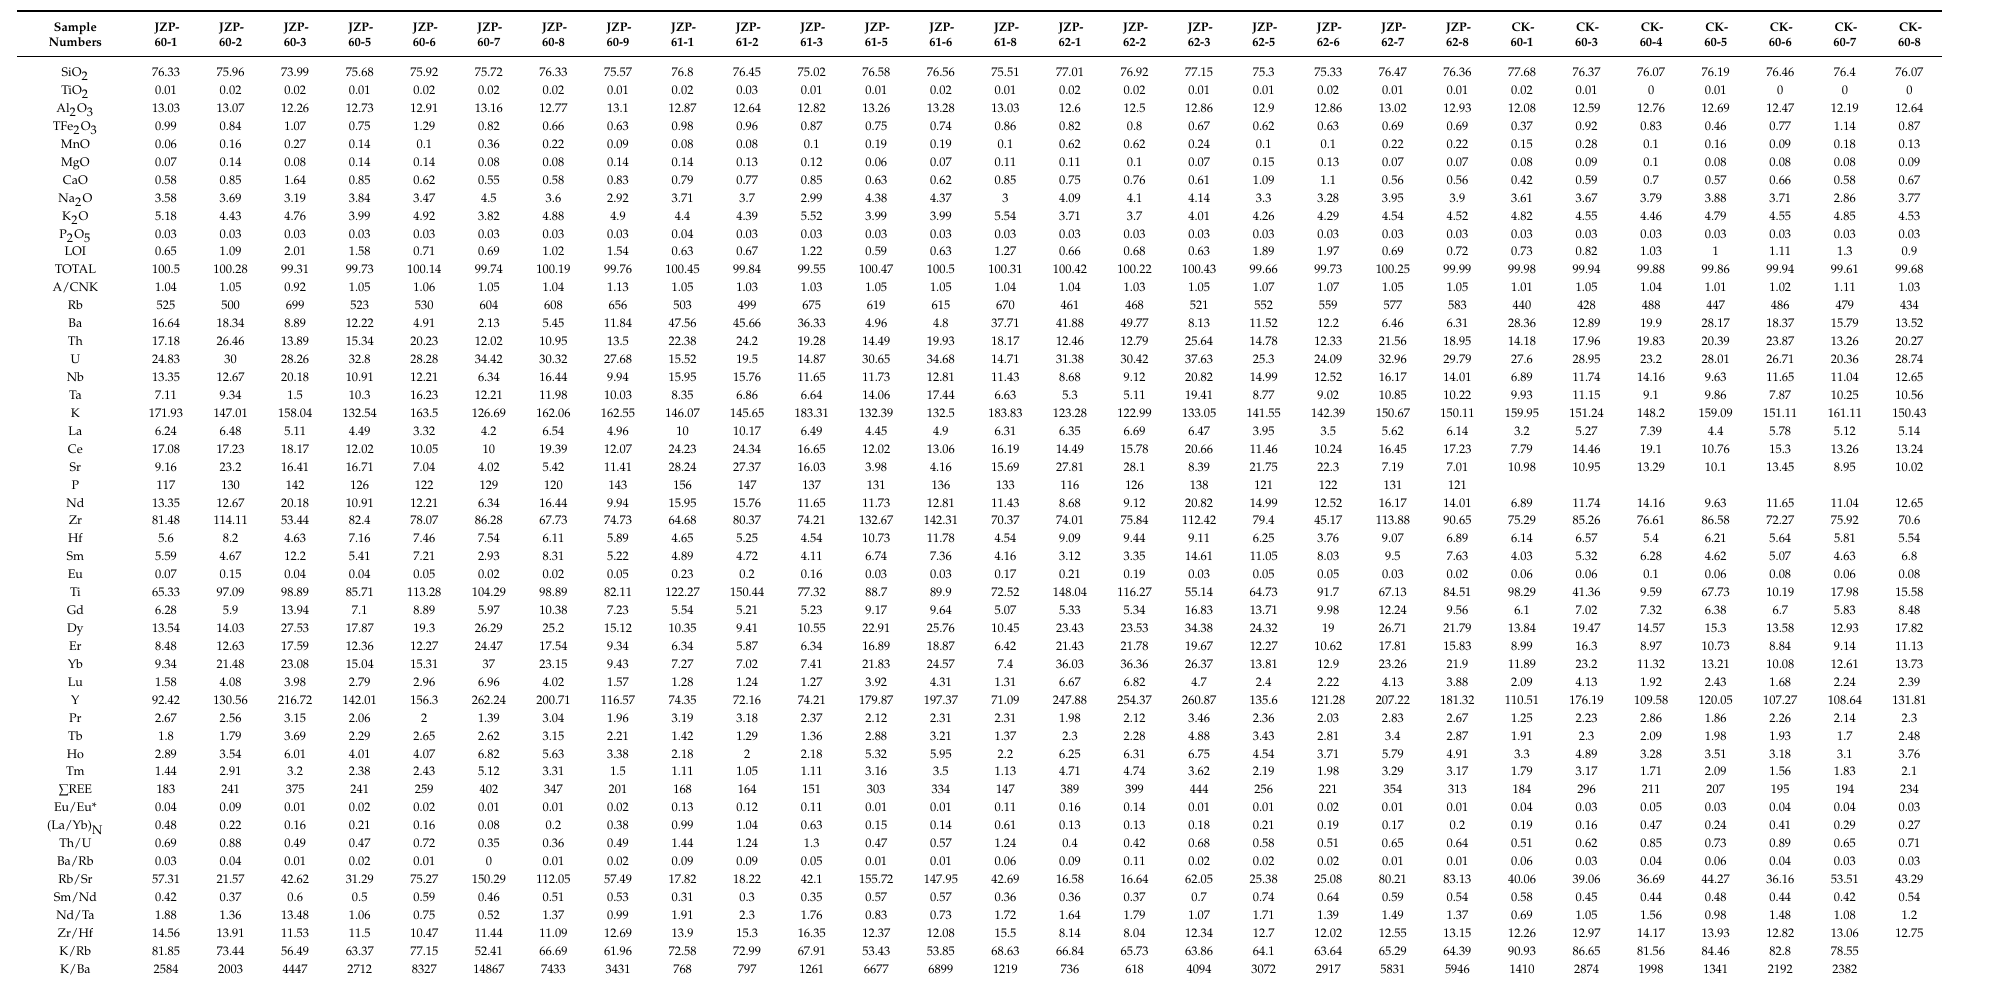
Table 1. Major and trace element compositions of the Helong